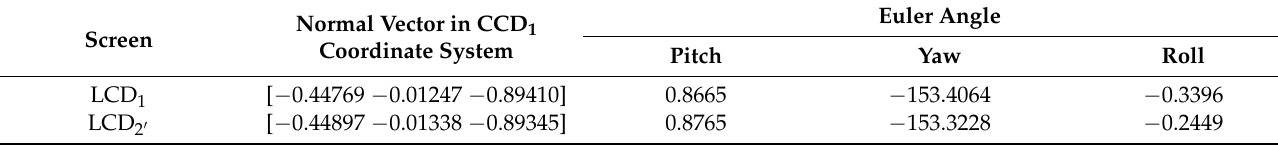
( b ) Figure 7. Reprojection error: ( a ) the reprojection error between LCD 1 and two cameras; ( b ) the reprojection error between LCD 2 ′ and two cameras.